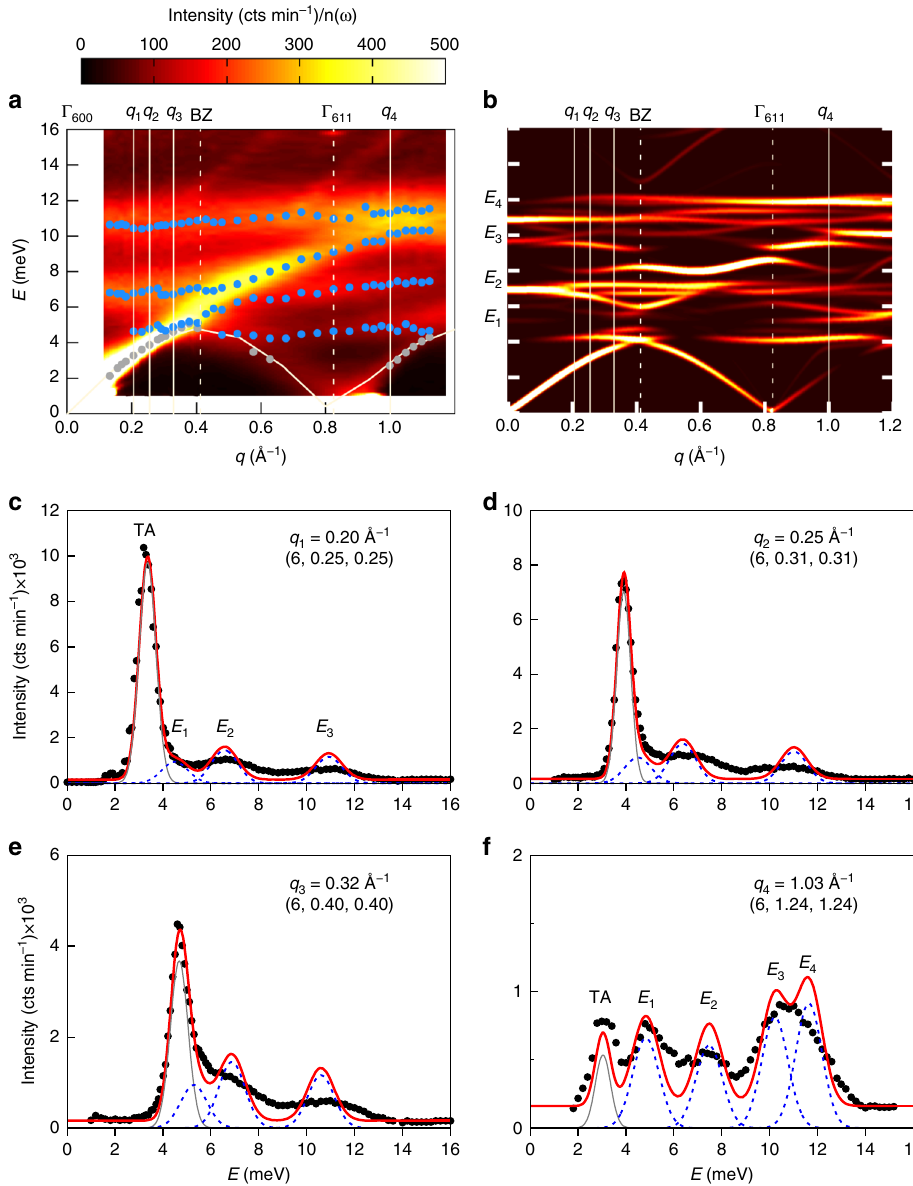
Fig. 3 Transverse acoustic (TA) phonon spectra in Ba 7.81 Ge 40.67 Au 5.33 : experiment vs. simulation at 300 K. a Two dimensional neutron intensity distribution as experimentally measured on a neutron triple axis spectrometer (2T@LLB), along the reciprocal direction (6, h , h ) from the Brillouin zone centre Γ 600 ( Q = 3.6 Å − 1 ) showing the TA 100 dispersion and its hybridization with low-lying optic Ba and Au modes ( red is higher intensity). Grey and blue 011 full circles stand for acoustic and optical excitations respectively as extracted from individual constant q-scans. The solid white line is the TA 100 dispersion 011 relation fi tted from the individual constant q-scans as reported in c – f ). b Two-dimensional neutron intensity distribution obtained by harmonic simulation in the density functional theory. A different scaling factor has been applied for the acoustic (1.4) and optical (1.2) contributions (see text). Experimental points are shown as grey (acoustic) and blue (optic) full circles , respectively. c – f example of four constant q -scans, q 1 to q 4 as indicated by the white vertical lines in the mapping ( a , b ). Experimental data ( full black circle ) are compared with ab initio phonon calculations after convolution with the instrumental resolution ( red line ). Calculated, individual phonon modes are reported in light grey (acoustic) and blue dotted line (optic). The energy scan at Γ 611 ( f ), for which the acoustic intensity is low, makes possible a direct observation of the low-lying optical intensities analysed using four Gaussian pro fi les centered at energies E 1 , E 2 , E 3 and E 4